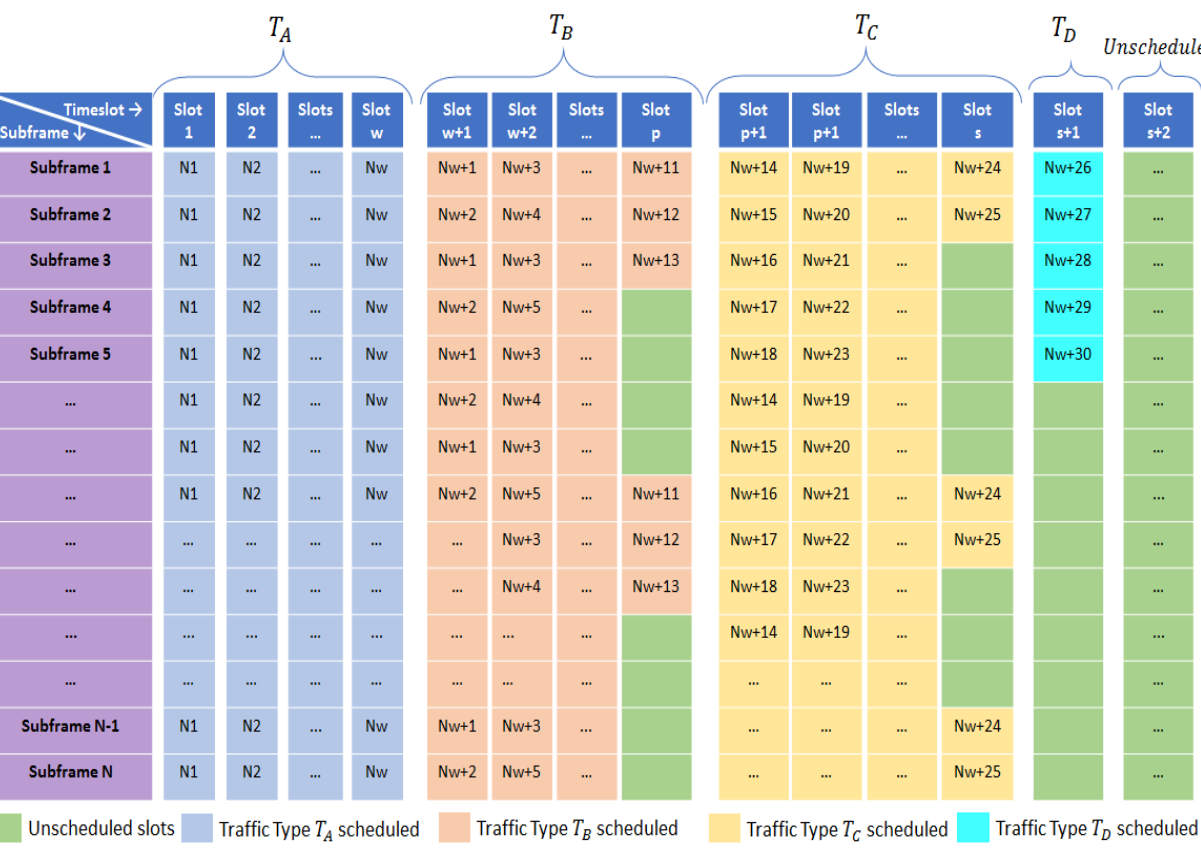
Figure 3 . Superframe communication schedule for nodes affiliated to